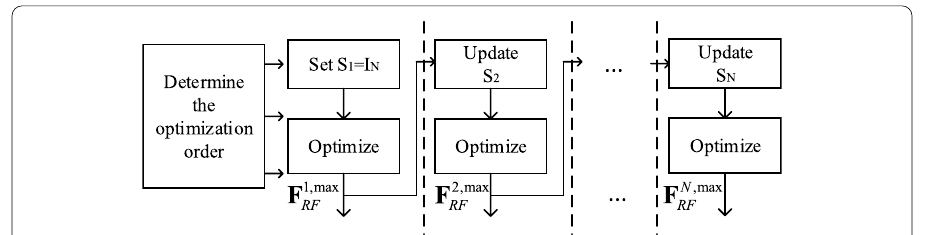
Fig. 2 The structure diagram of analog precoding solution process. It shows the analog precoding solution process. After determining the optimization order firstly, and then optimizing the sub-matrices one by one. The whole process only needs to update S